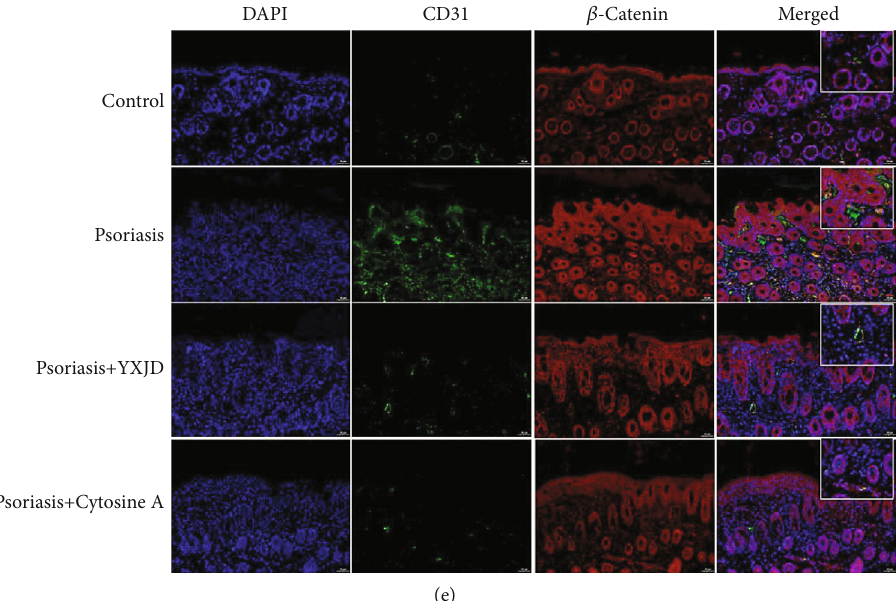
Figure 4: Protein levels of p-Akt, Akt, p-GSK3- β , GSK3- β , and β -catenin and the nuclear entry of β -catenin, as detected by Western blot, immunochemical staining, and immuno fl uorescence analysis YXJD inhibited the activation of the PI3K/Akt pathway. The levels of p-Akt, Akt, p-GSK3- β , GSK3- β , and β -catenin were reduced in YXJD-treated mice, as assessed by Western blotting (a – d). The nuclear entry of β -catenin (e) was decreased in the YXJD group mice compared with the model mice. Double immuno fl uorescence staining for CD31 (green) for vessels and β -catenin (red) in a representative skin sample from the 4 groups is shown. Nuclei were counterstained with DAPI